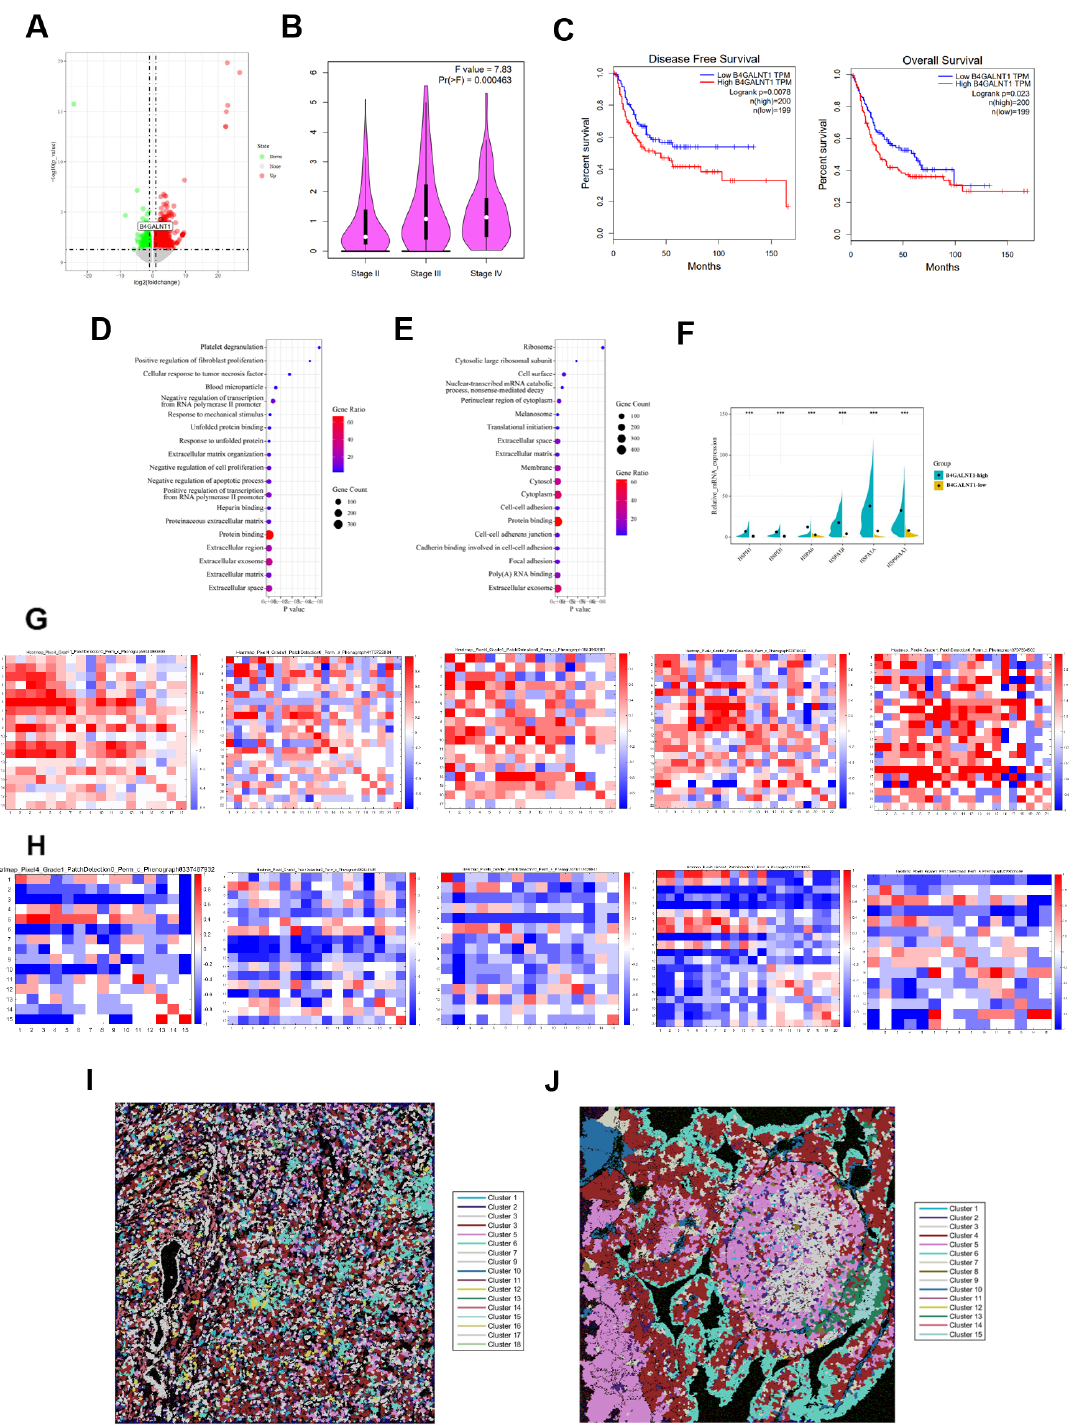
Figure 4. Cluster 6 is potentially regulated by B4GALNT1. ( A ) Volcano plot of the DEGs between cluster 6 high- and low-abundance groups. ( B ) Violin plot shows the B4GALNT1 expression levels of BLCA cohort in TCGA. ( C ) Disease-free survival and overall survival of B4GALNT1 high- and low-expression group patients in TCGA BLCA cohort. ( D , E ) GO analysis shows the top 20 pathways in which the DEGs of fibroblasts ( D ) or tumor epithelial cells ( E ) in B4GALNT1 high- and low-expression group are significantly enriched. ( F ) The expression levels of HSPH1, HSPD1, HSPA6, HSPA1B, HSPA1A, HSP90AA1 in B4GALNT1 high- and low-expression groups. ( G , H ) Interaction heatmap of 5 B4GALNT1 high-expression patients ( G ) and 5 B4GALNT1 low-expression patients ( H ). The red bands indicate interaction, and the blue bands indicate avoidance. ( I , J ) Clusters spatial distribution images of B4GALNT1 high ( I ) and low ( J ) expression patients, which were highlighted by histoCAT